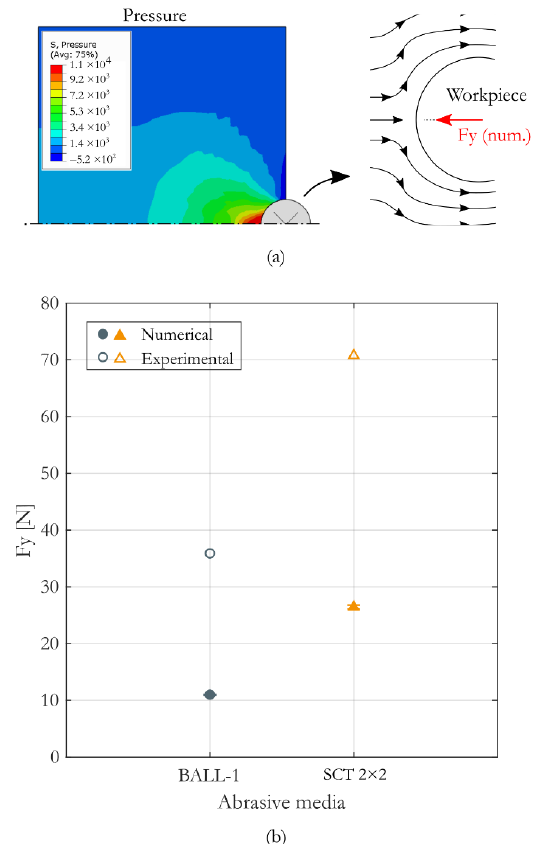
Figure 7. ( a ) The numerical force calculation and ( b ) the comparison between numerical and ex- perimental forces for each